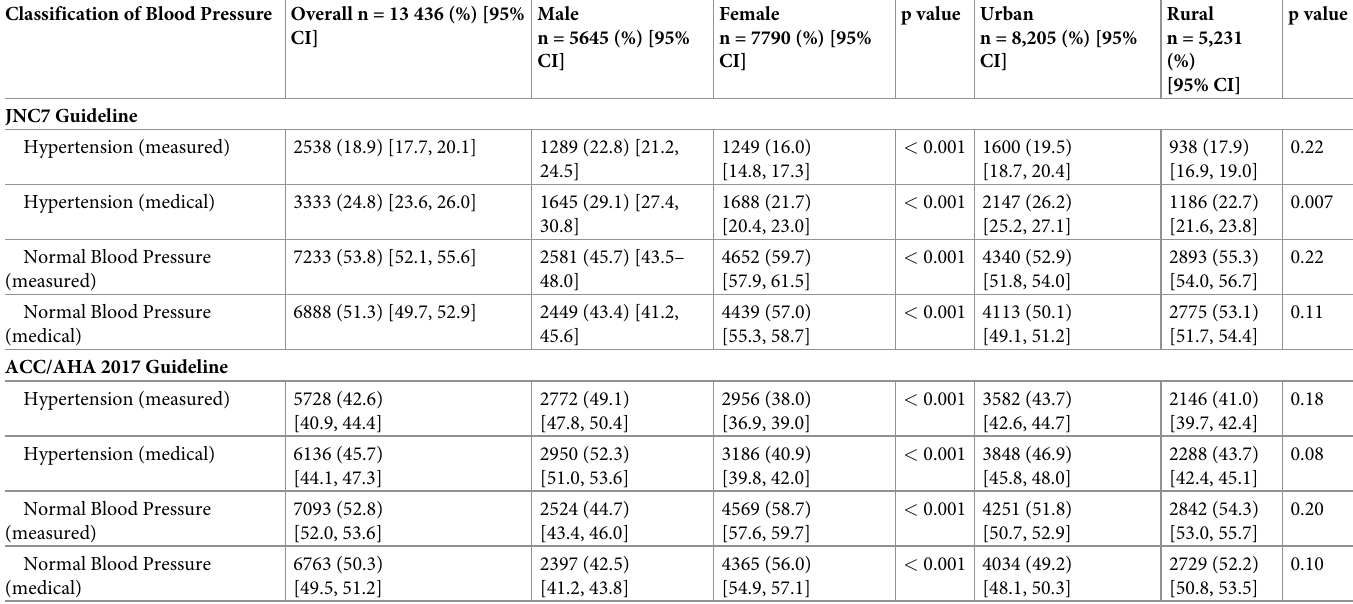
Table 3. Prevalence of hypertension by sex and urbanity in Nepal. Classification of Blood Pressure Overall n = 13 436 (%) [95%